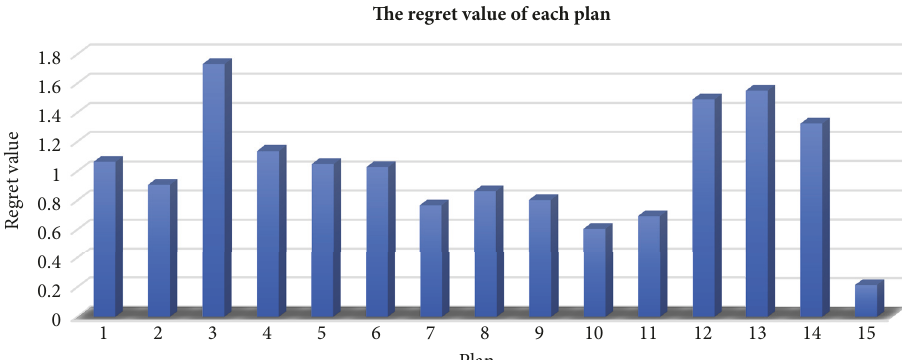
Figure 7: The regret value of each